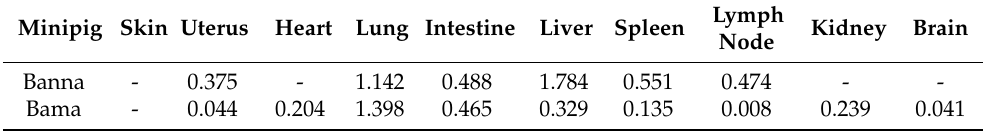
Table 3. Tissue expression profiles of PoIFN ‐β of two Chinese miniature pig breeds. Minipig Skin Uterus Heart Lung Intestine Liver Spleen